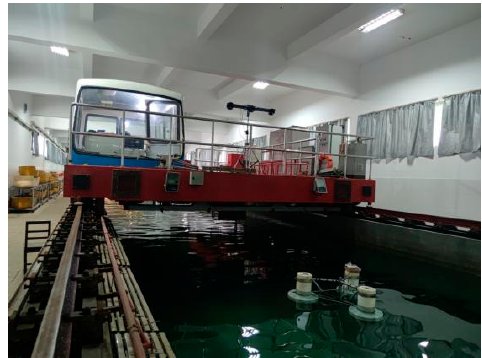
Figure 10. Installation diagram and capture system.